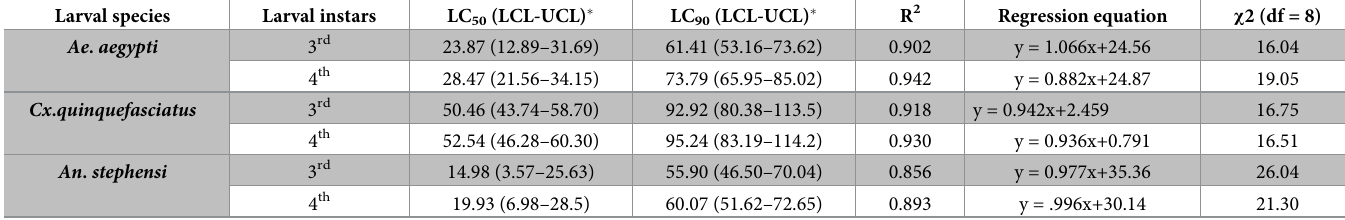
Table 7. Lethal concentrations, R 2 , Regression equations and χ 2 values for larvicidal activity of AgNPs synthesized by Bacillus marisflavi against Ae . aegypti , Cx . quinquefasciatus and An . stephensi